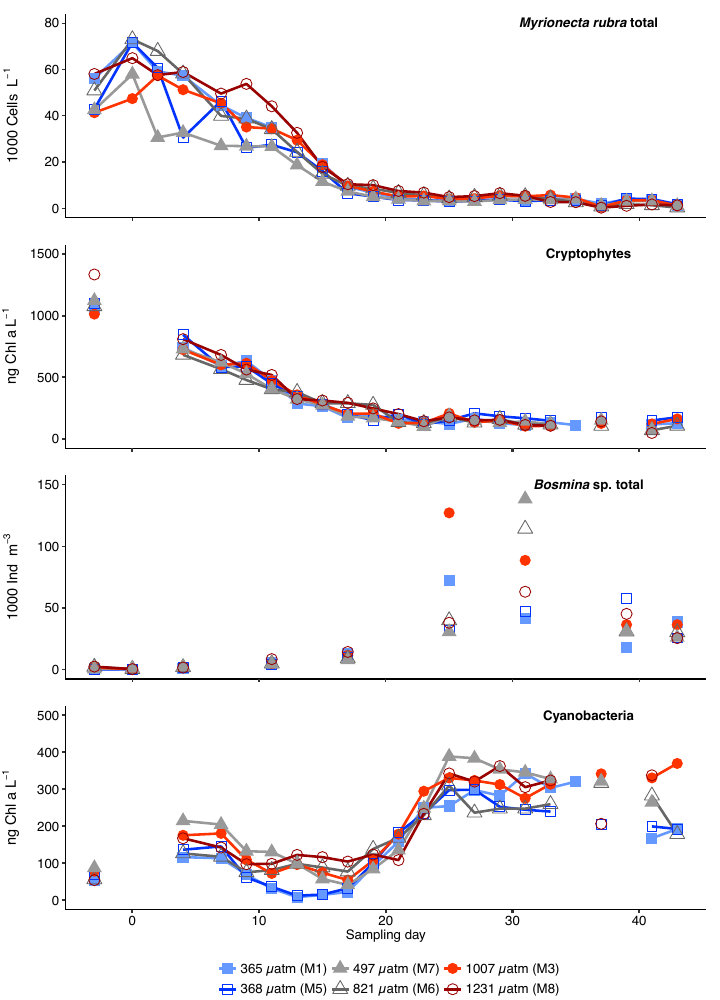
Figure 9. Succession of total cell numbers of Myrionecta rubra , total biomass of Cryptophytes, total abundance of Bosmina sp., and total biomass of Cyanobacteria during the course of the experiment. According to temperature variations and the first CO 2 manipulation, different experimental phases were defined: phase 0 = t − 5 to t 0 , phase I = t 1 to t 16 , phase II = t 17 to t 30 , phase III = t 31 to t 43 . Note that there is one missing value in M1 on t 13